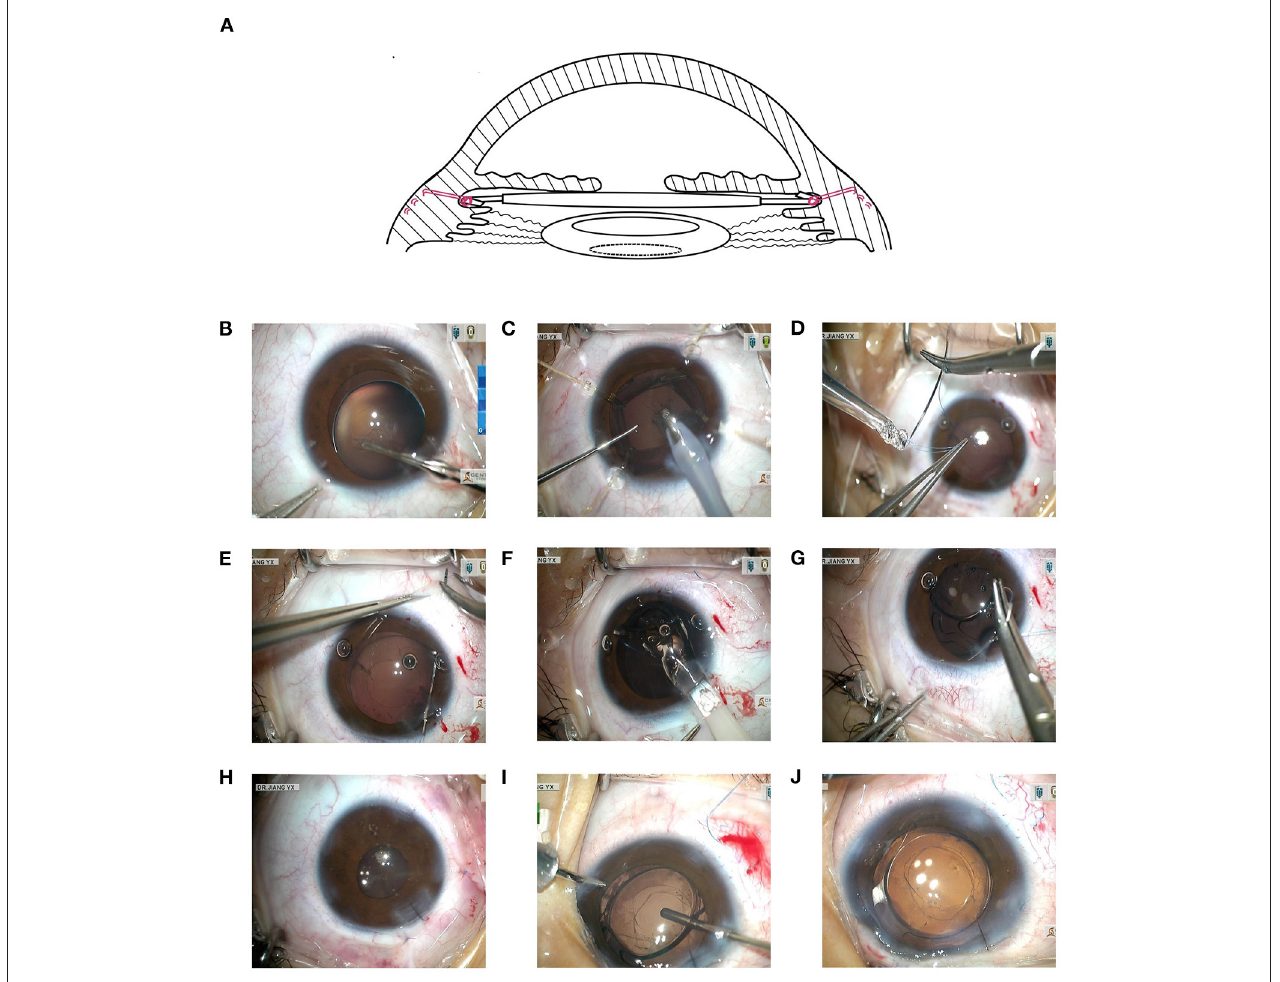
FIGURE 1 | Detailed processes of SCSF-IOL in MSP. (A) A demonstration of the principles of the SCSF-IOL procedure. The intraocular lens was sutured with 9–0 polypropylene (in red) through the sulcus and placed above the preserved capsule. Prophylactic posterior capsulotomy is shown within the dashed circle. (B) Continuous circular capsulorhexis was carefully performed. (C) The lens was removed using irrigation/aspiration (I/A) mode at reduced vacuum, slow aspiration flow rate, and low bottle height, with the aid of four capsular hooks. (D) Double-strand 9–0 polypropylene was used to suture one loop of the pre-loaded IOL. (E) A puncture point was made using the ab interno approach at 1.5–2.0mm posterior to the corneal limbus. (F) The pre-loaded IOL with the pre-sutured loop was injected into the anterior chamber through a 2.6-mm clear corneal tunnel incision. (G) The other loop was sutured opposite to the previous one. (H) The main incision and conjunctival flap were closed. (I) For young patients who were expected to be uncooperative during laser capsulotomy, the posterior capsule of the visual axis was excised and limited anterior vitrectomy was performed via the limbus with the cutter in cut I/A mode. (J) At the center of the IOL, the anterior and posterior capsulorhexis openings were checked at the end of the surgery. This is shown in the same eye as in (I) . SCSF-IOL, supra-capsular and scleral-fixated intraocular lens implantation; I/A, irrigation/aspiration; MSP,